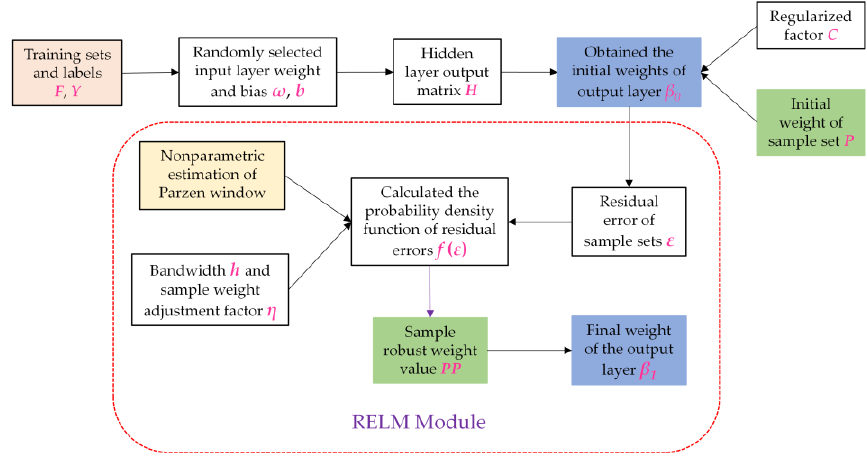
Figure 4. Framework flow of the robust extreme learning machine (RELM) Model.